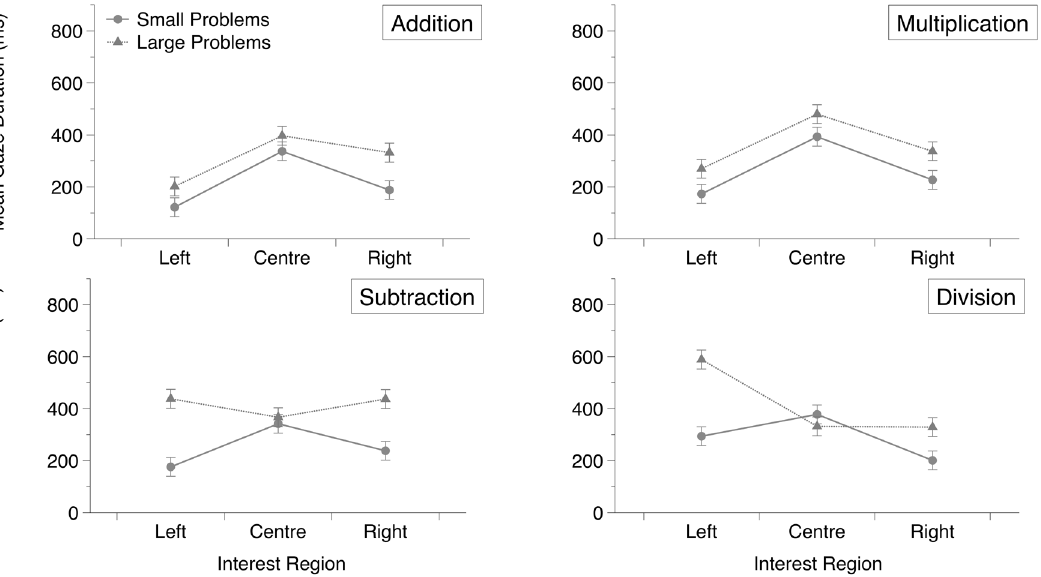
Figure 2. Mean gaze duration as a function of operation, problem size, and interest area. Error bars represent 95% confidence intervals.